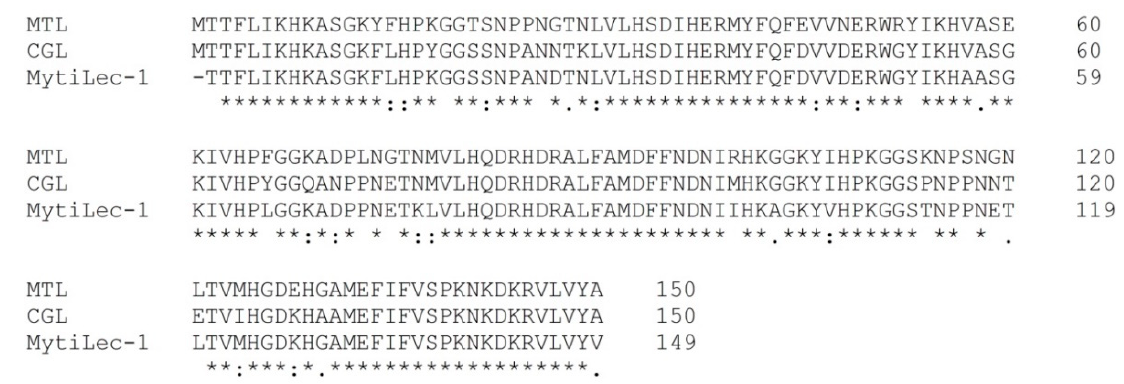
Figure 1. Alignment of MTL (AKI29293.1), CGL (AEY80387.1) and MytiLec-1 (B3EWR1) generated by Clustal Omega (https://www.ebi.ac.uk/Tools/msa/clustalo/).